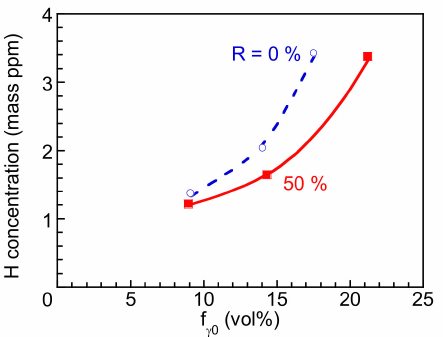
Figure 13. Variations in hydrogen embrittlement susceptibility ( HES ) as functions of ( a ) initial volume fraction ( f γ 0 ), ( b ) initial carbon concentration ( C γ 0 ), and ( c ) total carbon content ( f γ 0 × C γ 0 ) in retained austenite in steels A, B, and C. R represents reduction ratio.